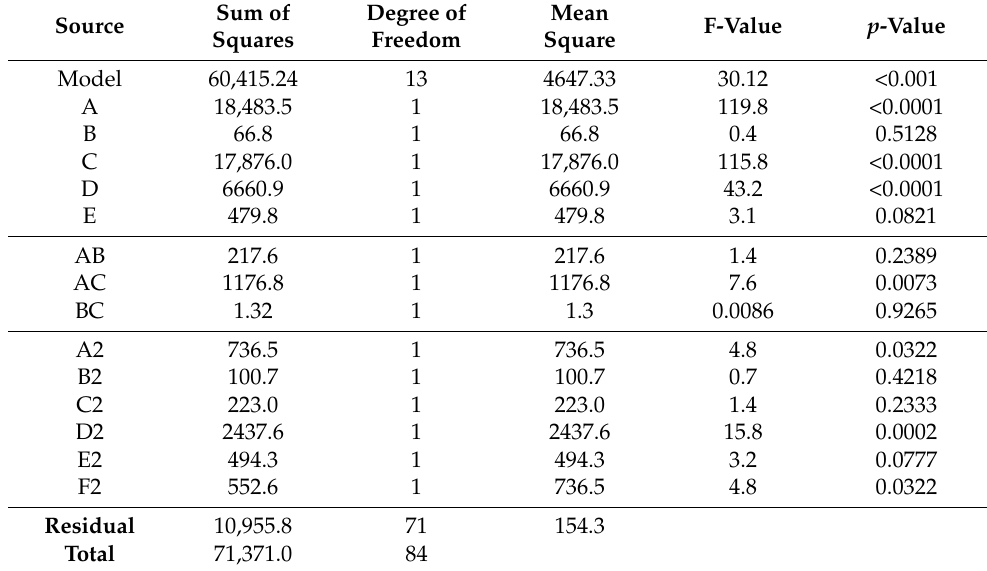
Table 7. ANOVA table of BG-HNT